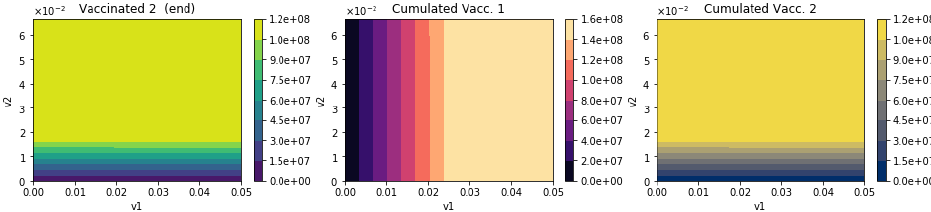
Figure 6. Number of vaccinated individuals from the 55+ age group at the end of simulation and the total number of vaccinated for each age group. The transmission rate of people in the 55+ age group is half of the transmission rate of 15–54 years-old. Vaccine efficacy is assumed 90%, v 1 = 0.05 and v 2 =